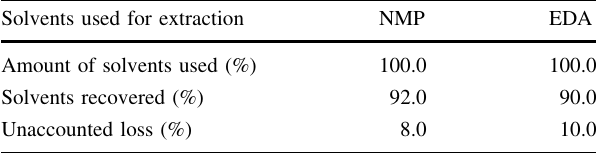
Table 13 Amount of solvents recovered during the extraction